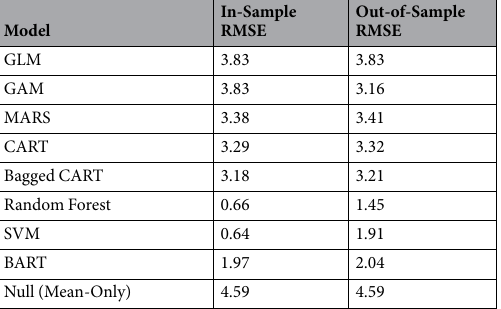
Table 1. Results from the initial performance analysis of the